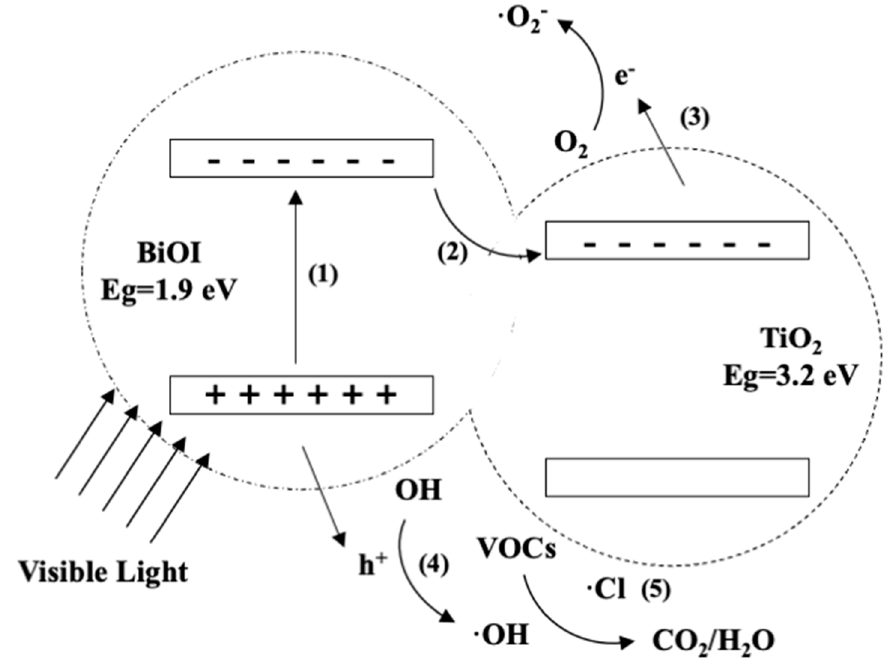
Figure 6. Mechanism of photoexcitation on the BITH heterojunction.